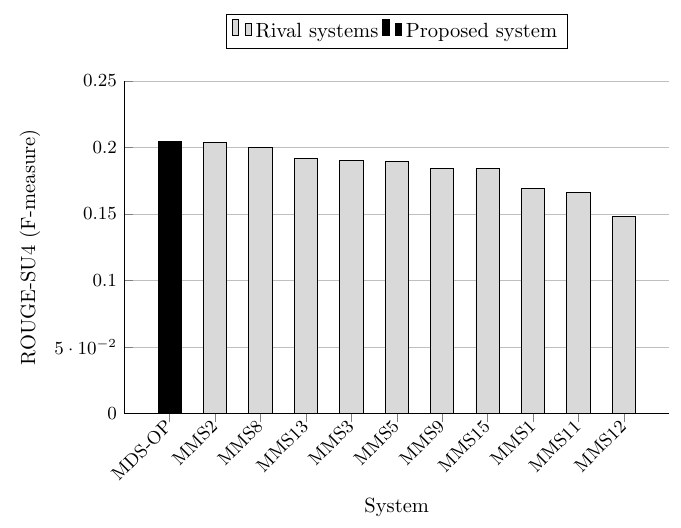
Figure 11. ROUGE-SU4 scores (F-measure) on MultiLing 2015 (MMS task).